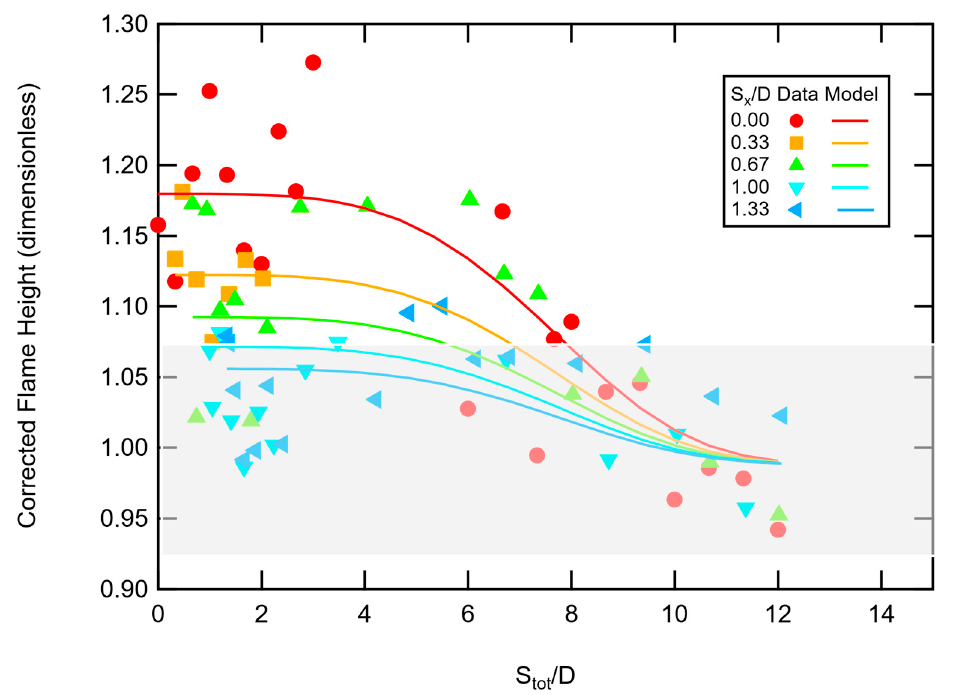
Figure 11. Corrected flame heights of experiments with two pads, plotted against dimensionless separation distance of the fuel sources. Lines are curve fits based on Equation (8).